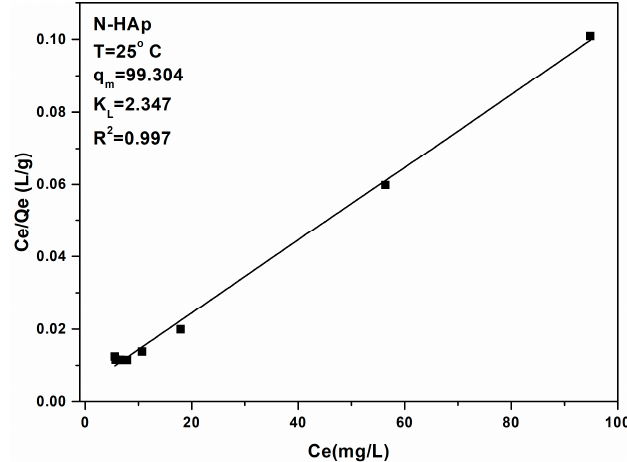
Figure 6. Langmuir linearized fits for the adsorption of lead ions on N-HAp.